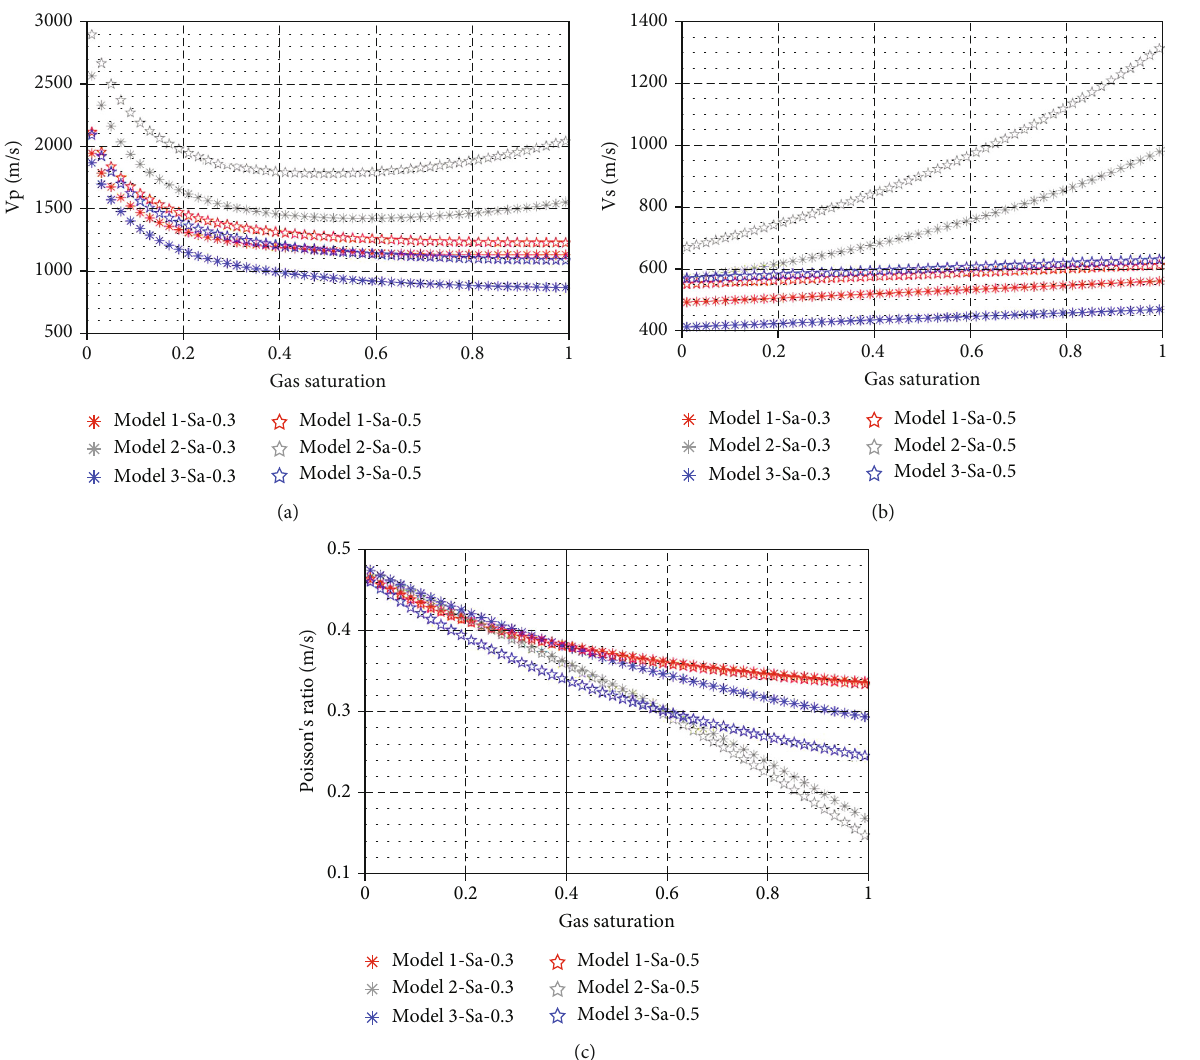
Figure 9: Variations in the elastic parameters of a hydrate-bearing rock formation with gas saturation. Model 1 is a pore- fi lling model, Model 2 is a thermodynamic elastic model, and Model 3 is a particle cementation model. (a) Relationship between V saturation; (b) relationship between V and gas saturation; (c) relationship between Poisson ’ s ratio and gas s